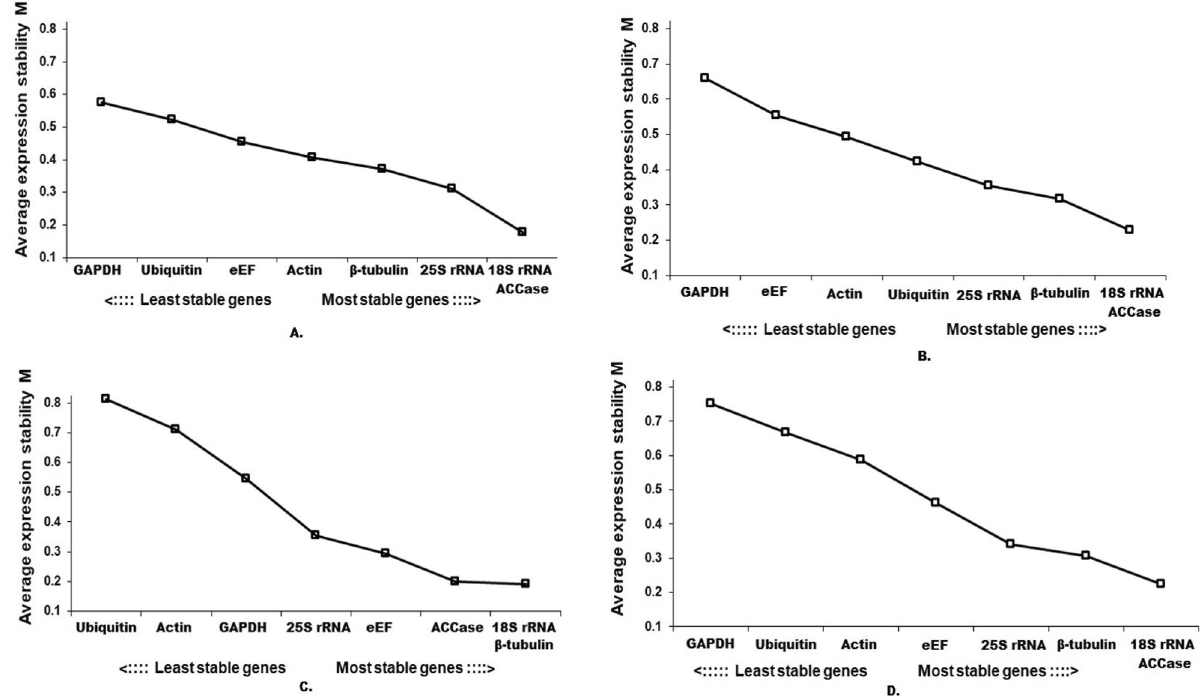
Figure 2. geNorm ranking of the candidate genes under different tested conditions. ( A ) Developmental stages, ( B ) plant organs, ( C ) Drought stress, and ( D ) All combined.